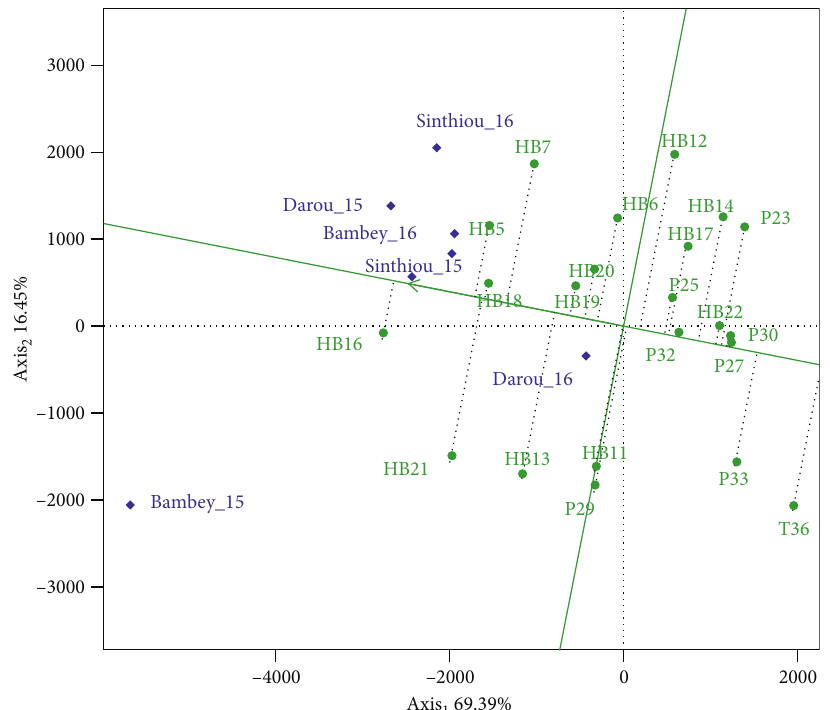
Figure 2: Average-environment coordination (AEC) view of sorghum hybrids and their parents for mean grain yield performance and stability based on GGE biplot analysis. The green single-arrowed horizontal line represents the AEC abscissa, and the green vertical line represents the AEC ordinate. The direction of AEC abscissa arrowhead indicates higher yield. The vertical projections on the AEC abscissa indicate stability of genotypes in either direction. Greater the projection, higher is the instability. Genotype and environment labels are represented in green and blue,